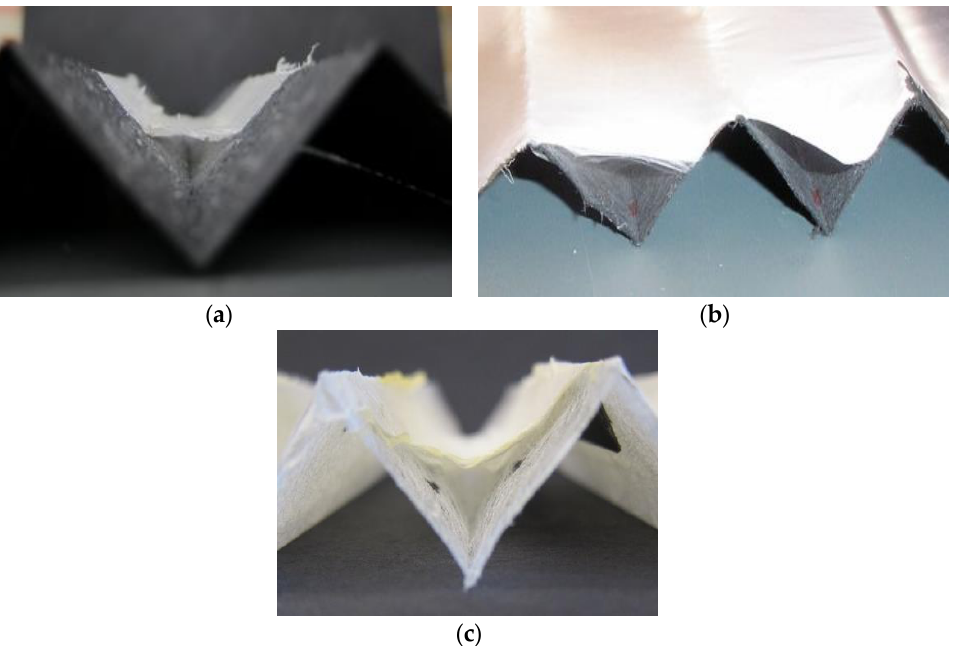
Figure 8. Photographic images showing nanofiber layers on cardboard and spun-bonded polypropylene (PP) substrates: ( a ) in the middle of the ‘V’ (location of 5 mm wide metal blades), ( b ) in the middle of the ‘V’ (location of 10 mm wide metal blades), and ( c ) nanofibers laid on the V-shaped spun-bonded PP substrate.